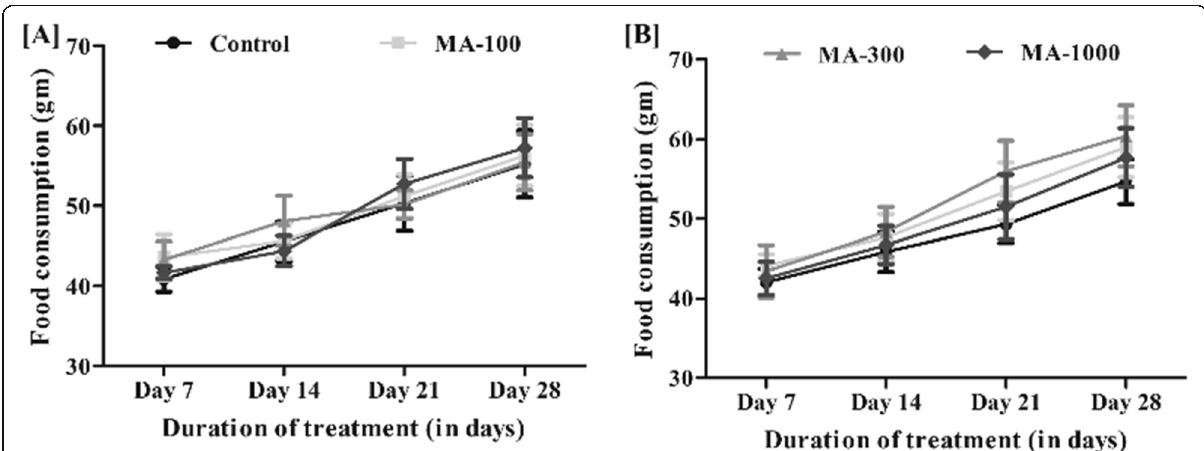
Fig. 6 Changes in food consumption of rats treated with MA for a period of 28 days. a Male rats and b female rats. The values were presented as mean ±